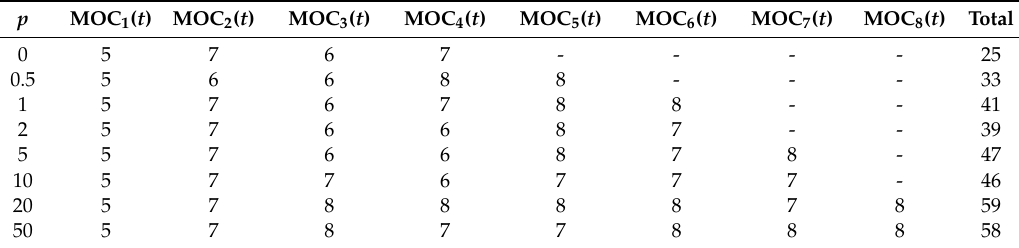
Table 2. The number of sifts versus the di ff erent values of the pole parameter p.